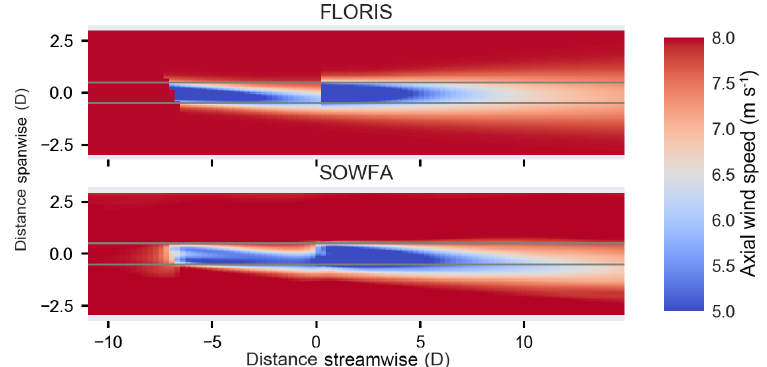
Figure 6. Horizontal cut-through of two-turbine flow in FLORIS and SOWFA. Gray lines pass through edges of rotor to help distinguish flow location relative to rotor.